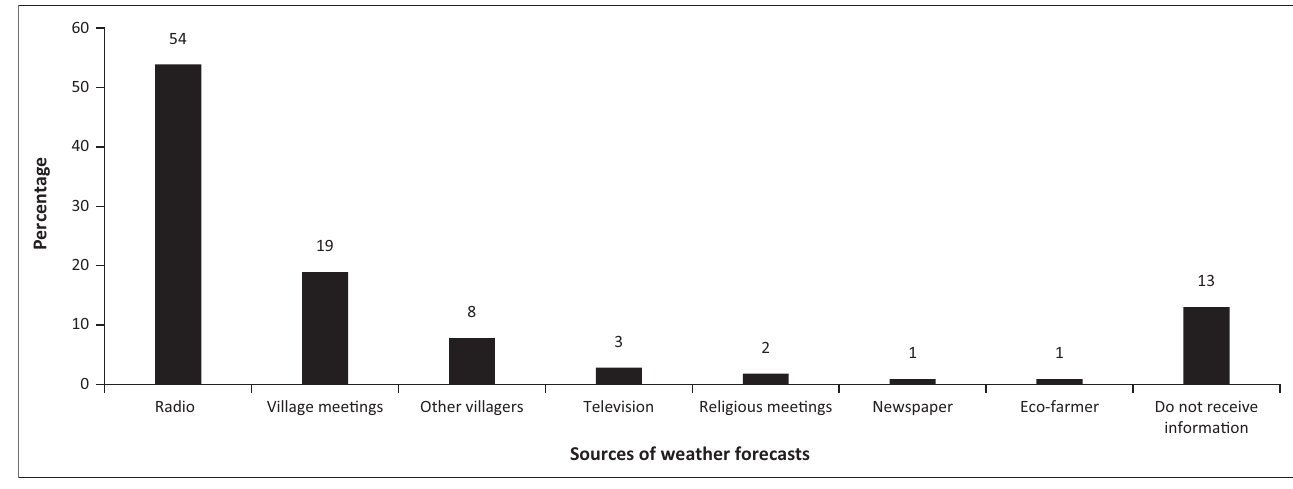
FIGURE 2: Conventional sources of weather forecasts ( n =